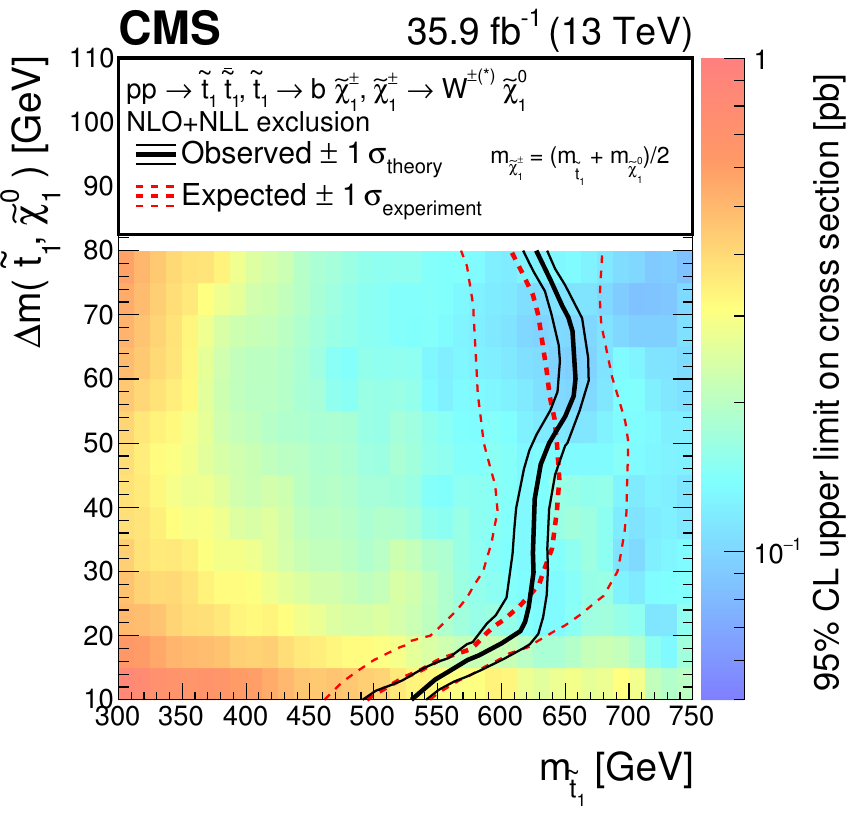
Figure 13 . Exclusion limits at 95% CL for top squark pair production followed by the decay ! bf (cid:22)f t 1 ! b (cid:31) (cid:6) (cid:31) 0 (T2bWC) in the mass plane (cid:1) m ( 0 1 1 and below the solid black curves represent the observed exclusion and the (cid:6) 1 standard deviation e contours for the NLO+NLL cross section calculations and their uncertainties [65]. The dashed red e curves represent the corresponding expectation at 95% CL and (cid:6) 1 standard deviation contours for the associated experimental